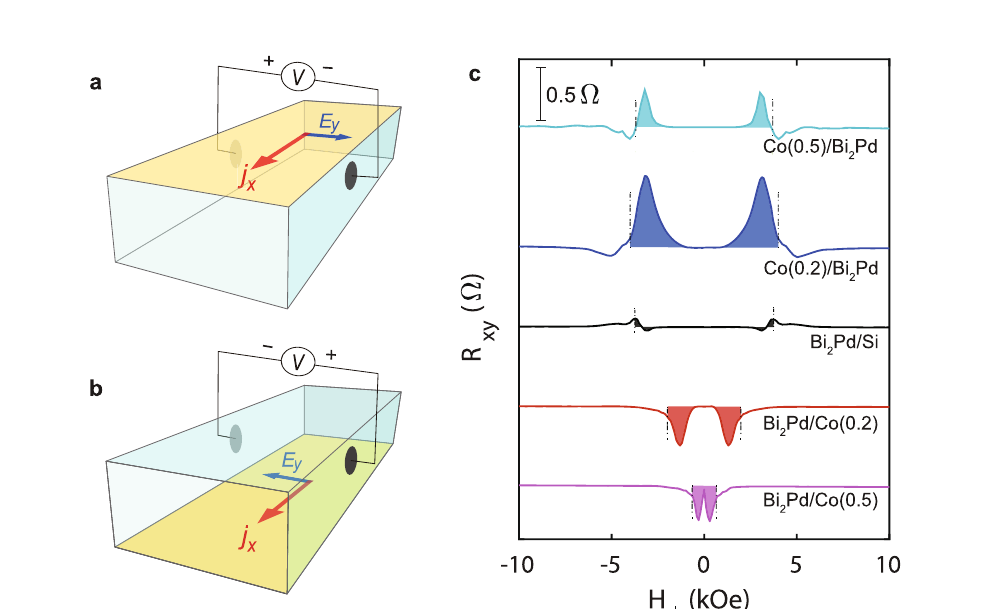
Fig.3|Transverseresistancewithcobaltlayerunderorontopof50nm β - Bi 2 Pd thin fi lms. Theschematic drawings illustratethe originoftransverse resistance( a ) when cobalt layer is on top of and b when cobalt layer is under Bi 2 Pd fi lm. c Transverse resistance (with arbitrary offsets for clarity) as a function of the magnetic fi eldof50nm-thickBi 2 Pd fi lmswithtoporbottominterfacesmodi fi edby